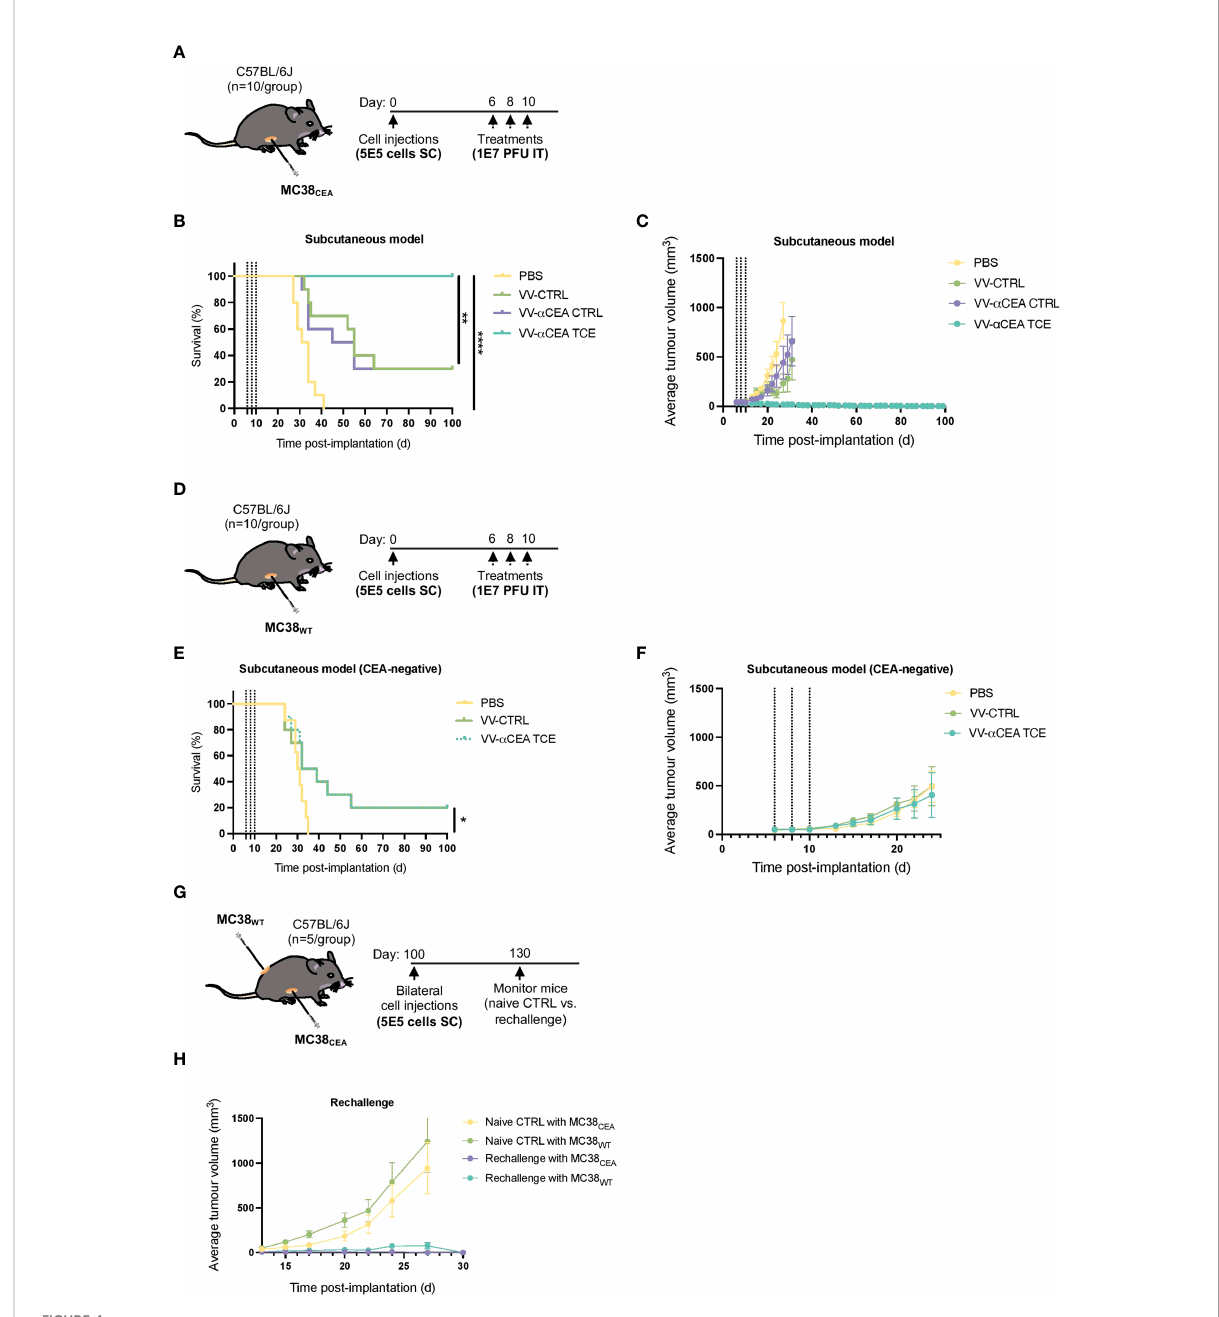
FIGURE 4 Antitumour ef fi cacy of VV encoding TCE in immunocompetent mouse models leads to cures and immunologic memory. (A) C57BL/6J mice bearing subcutaneous MC38 CEA tumours were injected intratumourally with 3 doses of viruses at 1E7 pfu, or PBS as control, at days 6, 8 and 10. (B) Antitumour ef fi cacies of VV-CTRL, VV- a CEA TCE (CEA:mCD3), and VV- a CEA CTRL ( a CEA:hCD3) viruses were assessed in immunocompetent mice. Mice bearing MC38 CEA tumours treated with viruses showed signi fi cantly prolonged survival compared to PBS controls. Of note, mice treated with VV- a CEA TCE were completely cleared of tumours and 100% cured. (C) Mice bearing MC38 CEA tumours treated with VV- a CEA TCE (CEA:mCD3) had the most signi fi cant decrease in average tumour volumes. (D) C57BL/6J mice bearing subcutaneous MC38 WT tumours were injected intratumourally with 3 doses of viruses at 1E7 pfu, or PBS as control, at days 6, 8 and 10. (E) Antitumour ef fi cacies of VV-CTRL, VV- a CEA TCE (CEA:mCD3), and VV- a CEA CTRL ( a CEA:hCD3) viruses were assessed